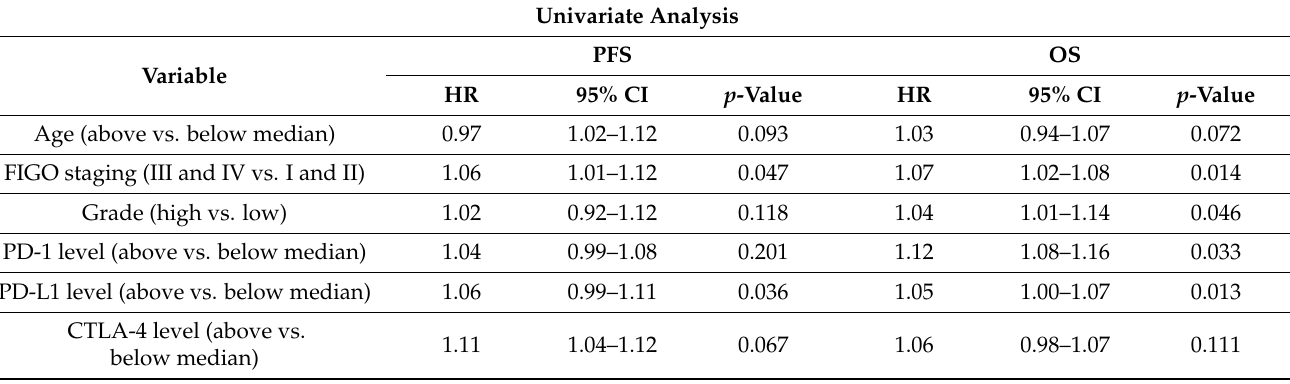
Table 9. Univariate and multivariate Cox regression model for concentrations of studied proteins in peritoneal